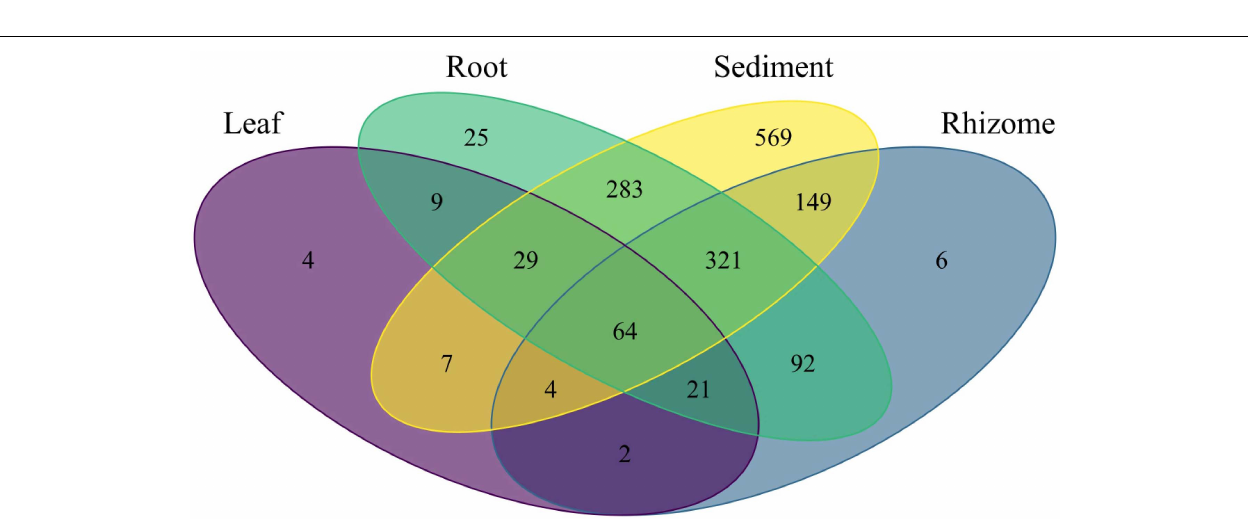
FIGURE 6 | Venn diagram showing the number of bacterial ASVs unique to each part and shared between parts.